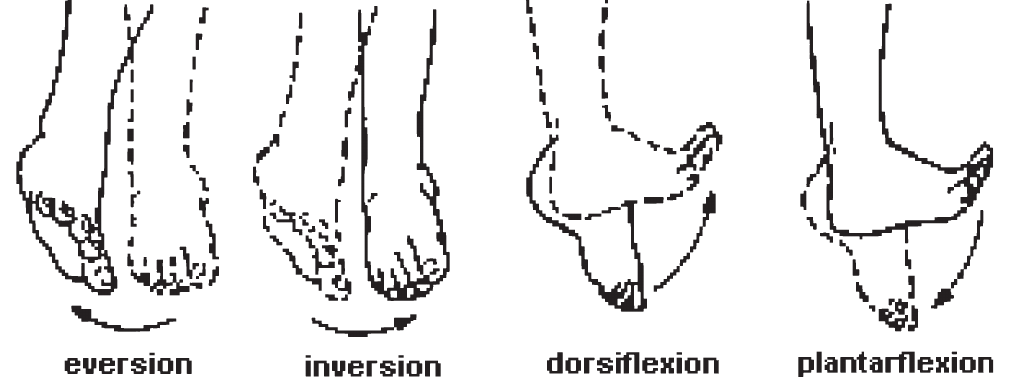
Fig. 4. Main rotations of the foot about the two axes of the